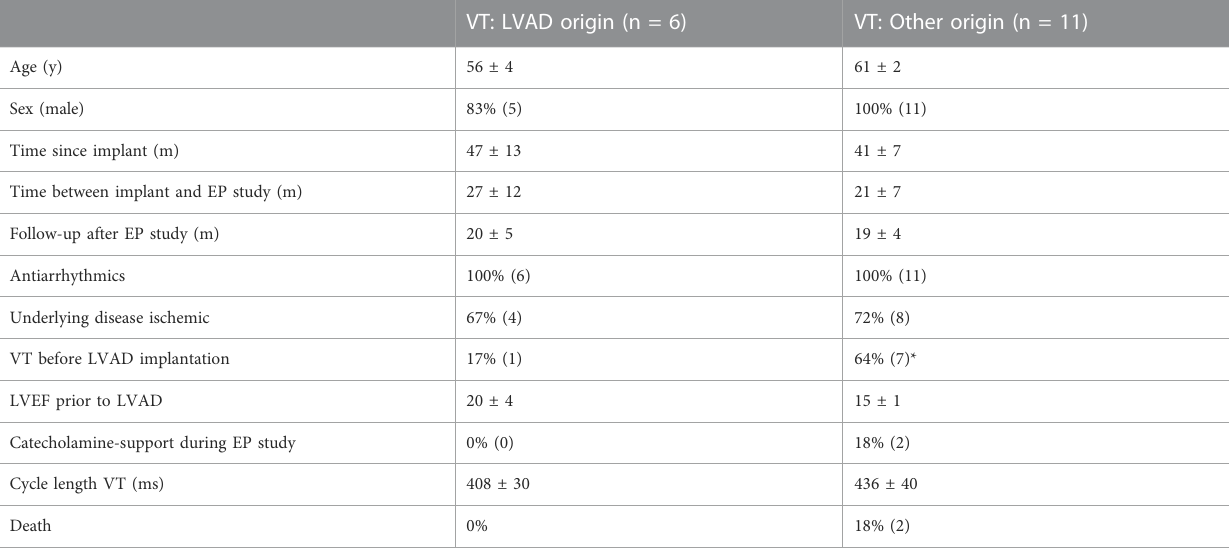
TABLE 1 Patient characteristics. * p < 0.05 for non-LVAD-association of